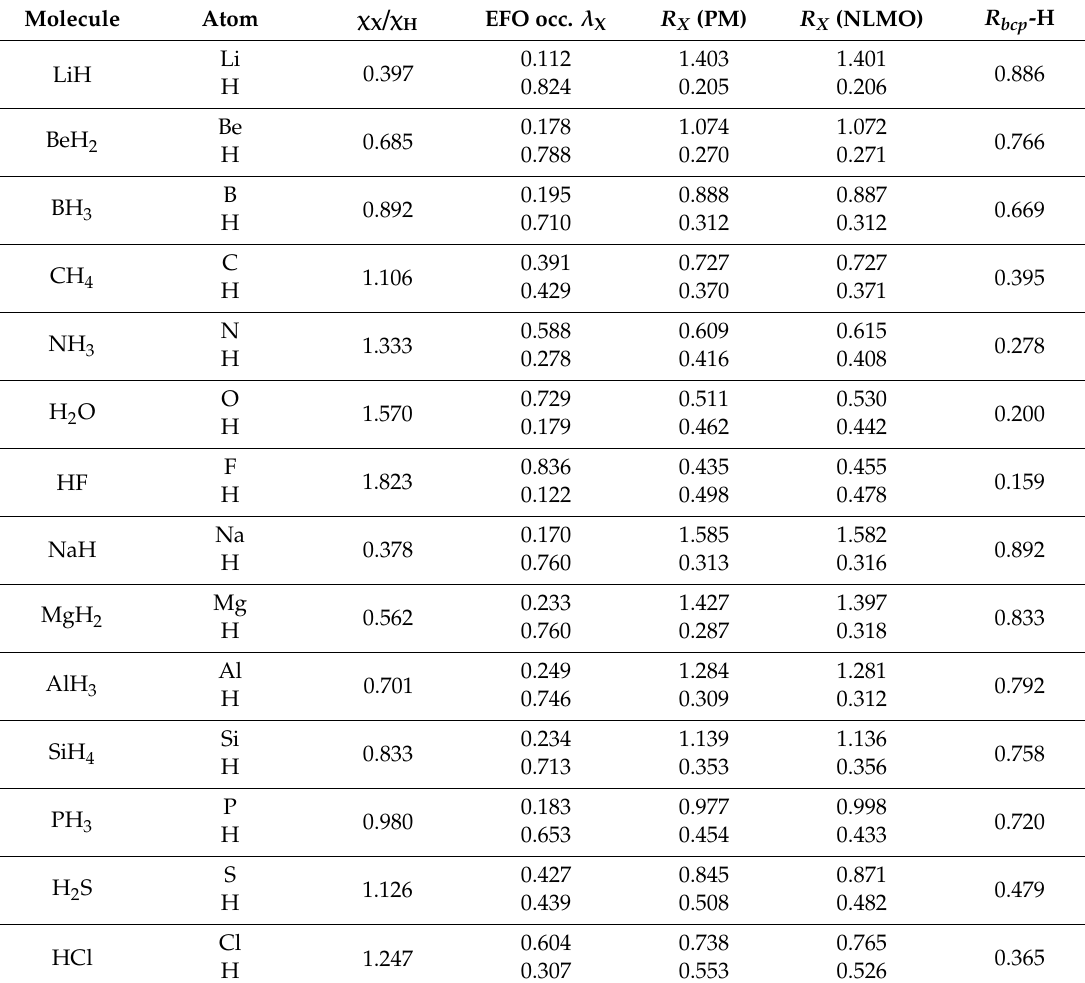
Table 1. Structural and electronic parameters of the hydrides studied, including Allen’s electronegativity (EN), bond distance, EFO occupancy, distance to the centroid (computed using the PM and NLMO localized orbitals) and distance to the bond critical point ( R bcp